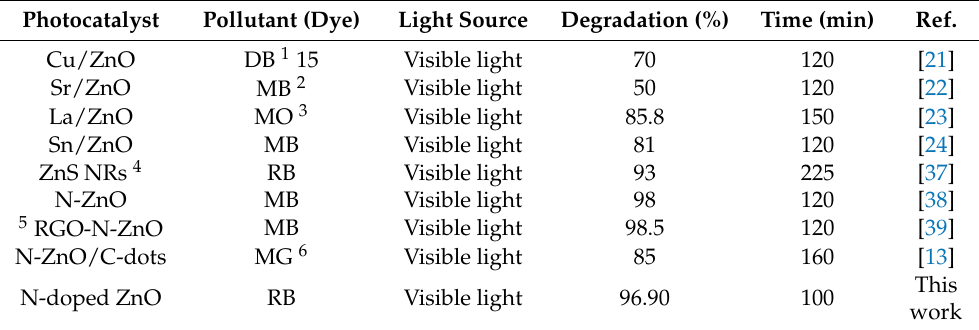
Table 2. A comparison of the photocatalytic degradation performance of various ZnO-containing photocatalysts.